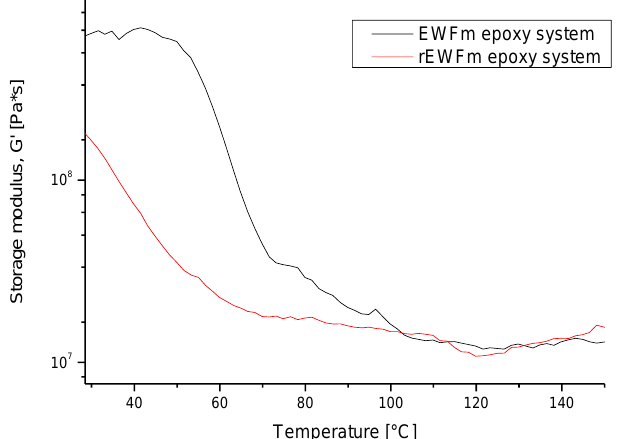
Figure 6. DMA on EWF-based epoxy systems.